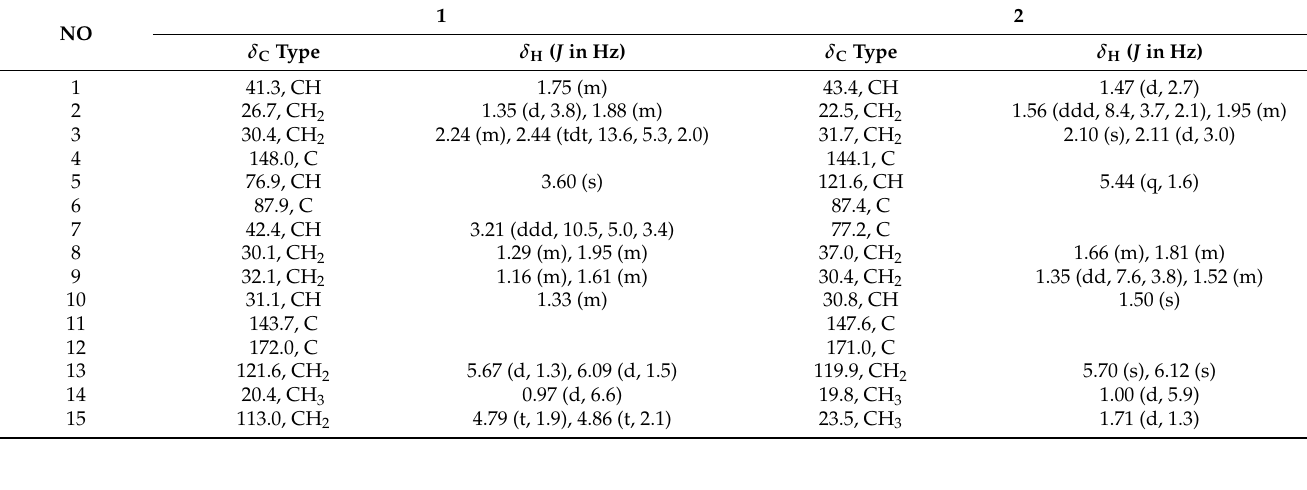
Table 1. 1 H-NMR (400MHz) and 13 C-NMR (100MHz) data of compounds 1 and 2 (MeOD, δ in ppm, J values in Hz).